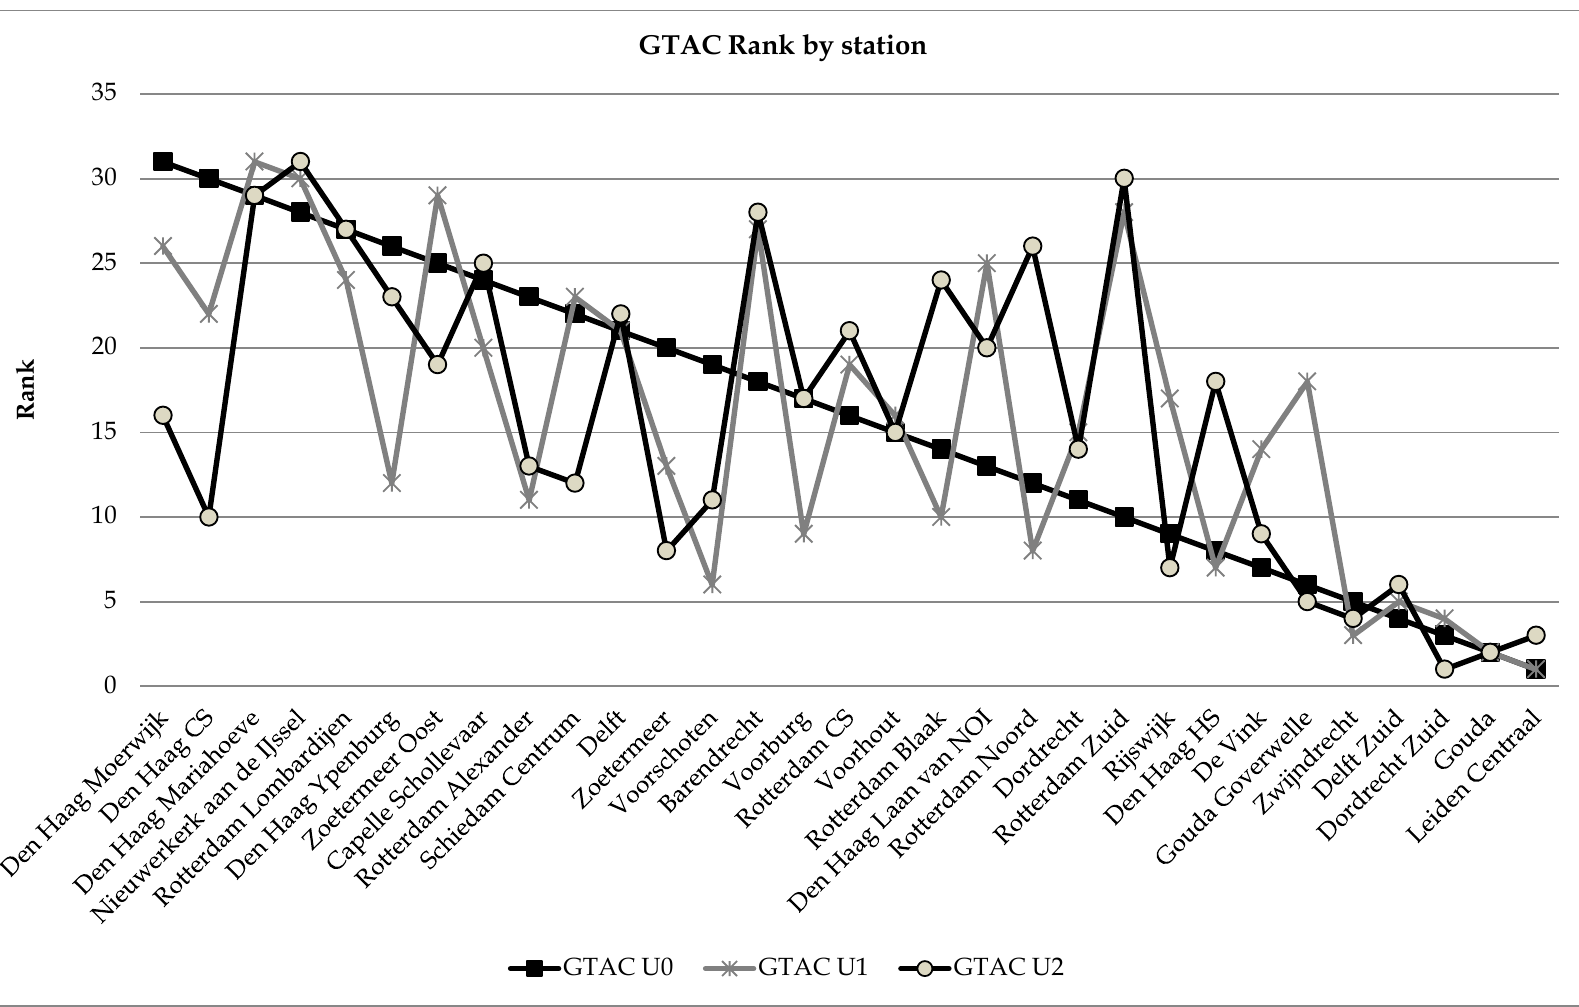
Figure 5. Rank of train stations by GTAC